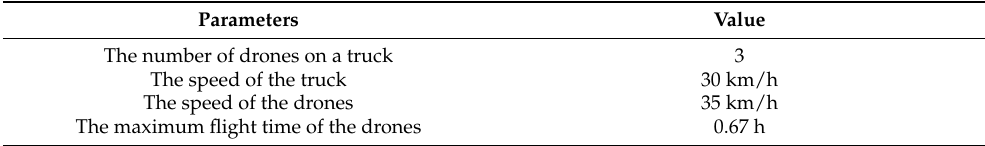
Table 3. Experimental parameter